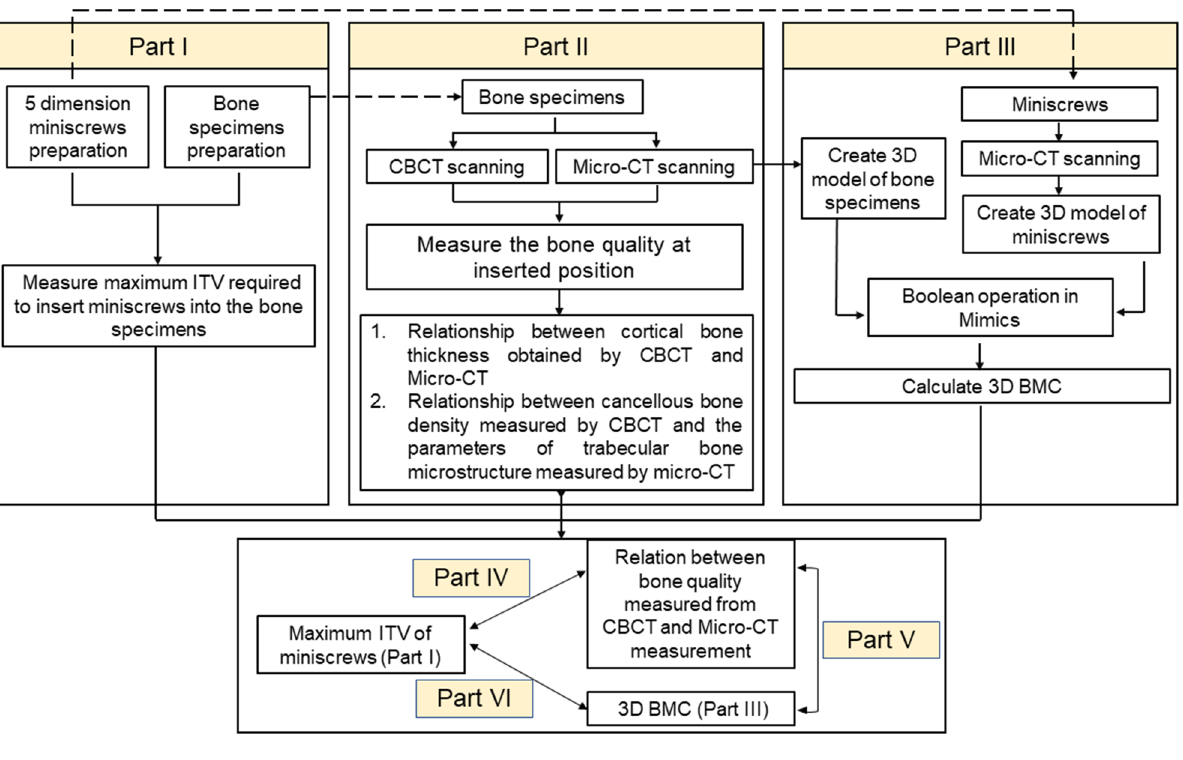
Figure 4. Outline of the